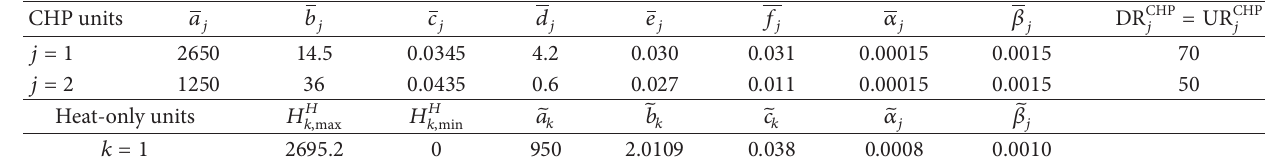
Table 3: Data of the CHP units and heat-only unit